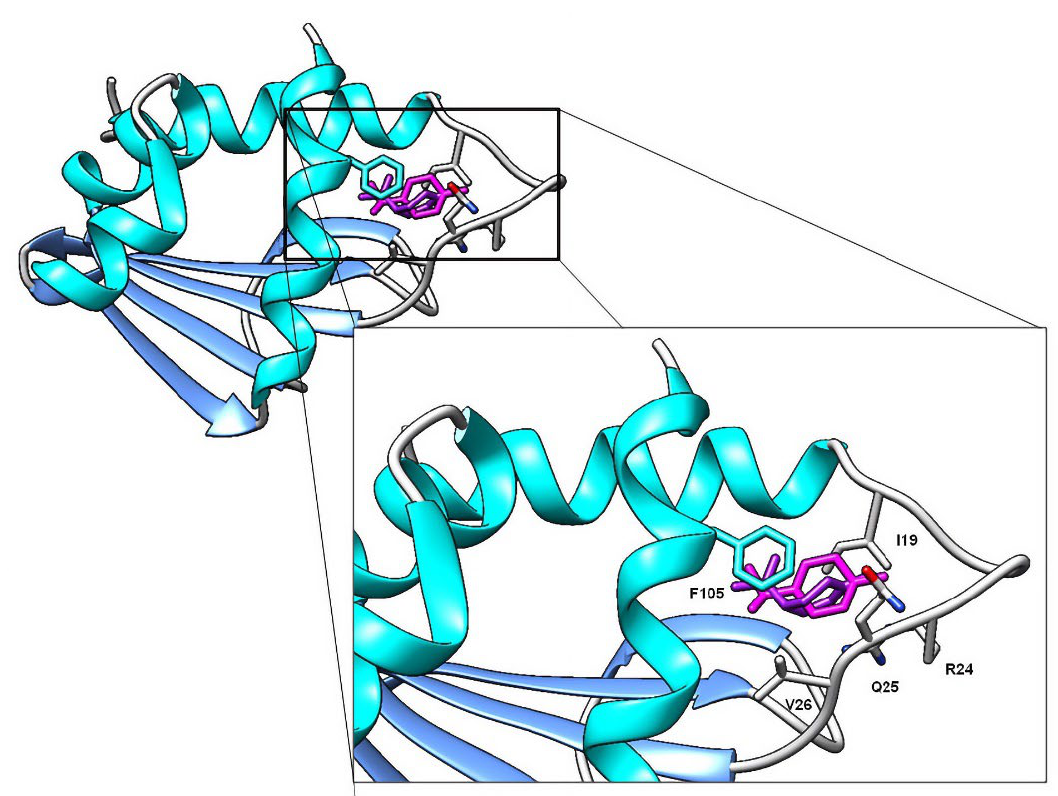
Figure 5. Docking studies to show the interaction of limonene (purple) and γ -terpinene (pink) with SCP-2.